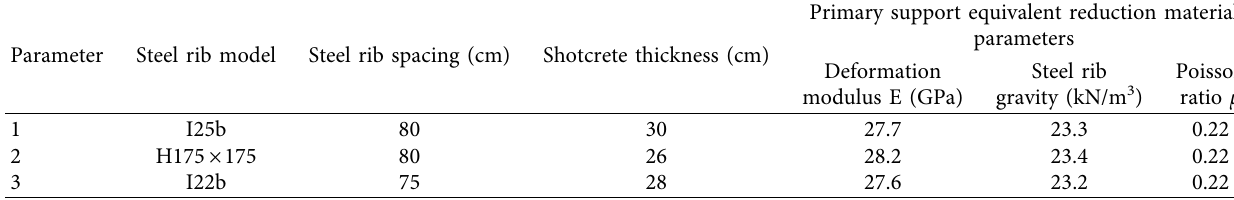
Table 7: Optimized parameters of primary support.